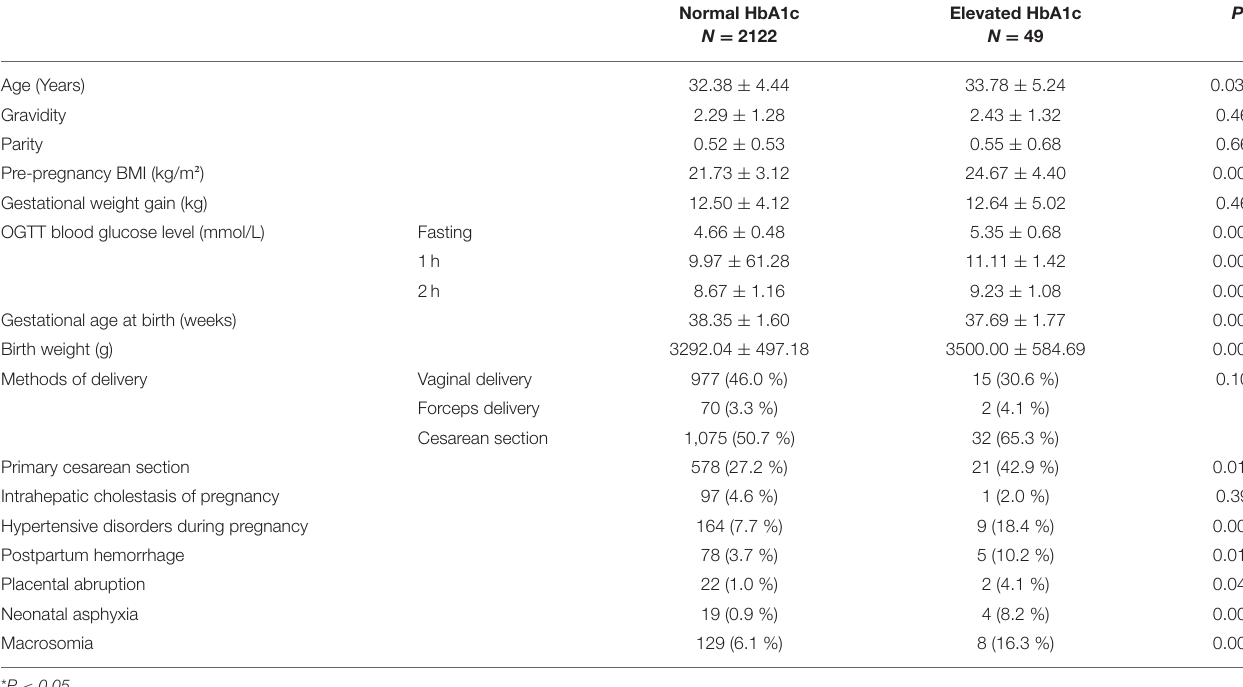
TABLE 1 | Comparison of general clinical characteristics and pregnancy outcomes between two groups with different glycated hemoglobin levels.